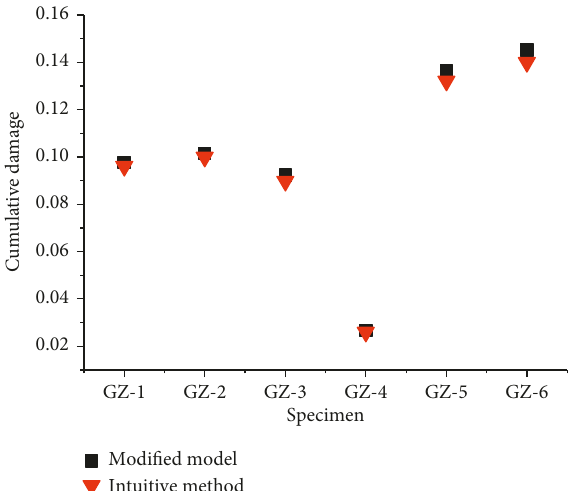
Figure 11: Cumulative damage